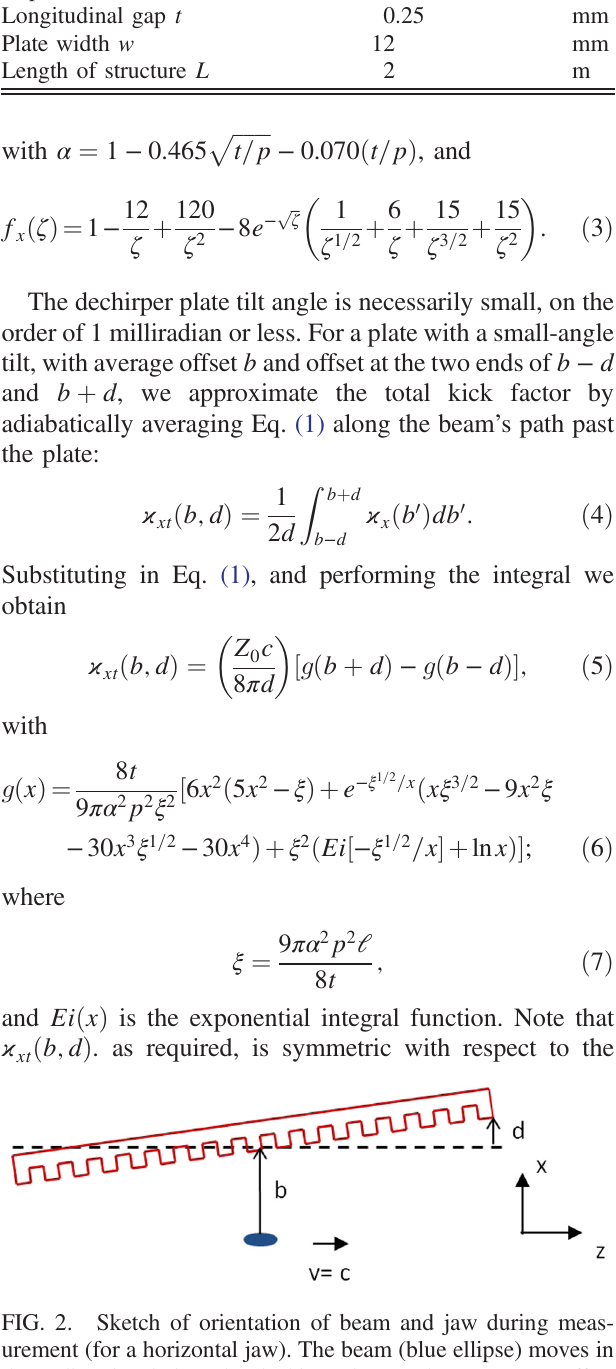
FIG. 1. Geometry of a (horizontal) dechirper module showing three corrugations. The blue ellipse represents an electron beam propagating along the z axis.